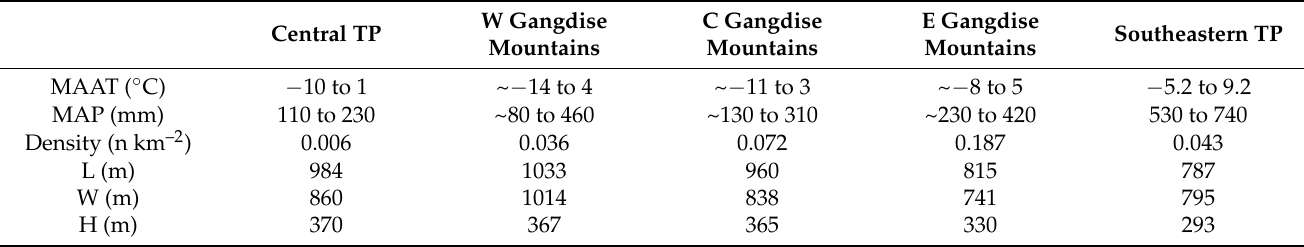
Table 6. Comparison of the cirque metrics (mean values) of the Gangdise Mountains, central TP, and this study a . W Gangdise C Gangdise Central TP Mountains Mountains